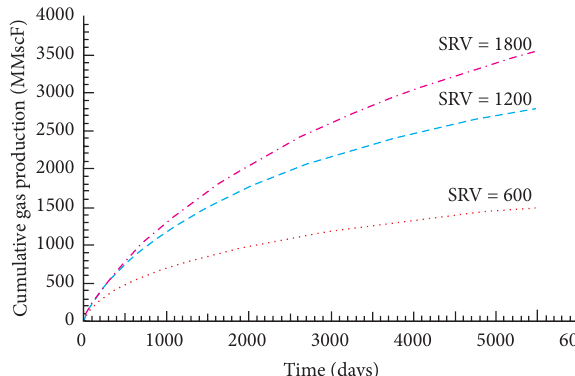
Figure 15: Effect of SRV on cumulative gas production for shale fracturing well